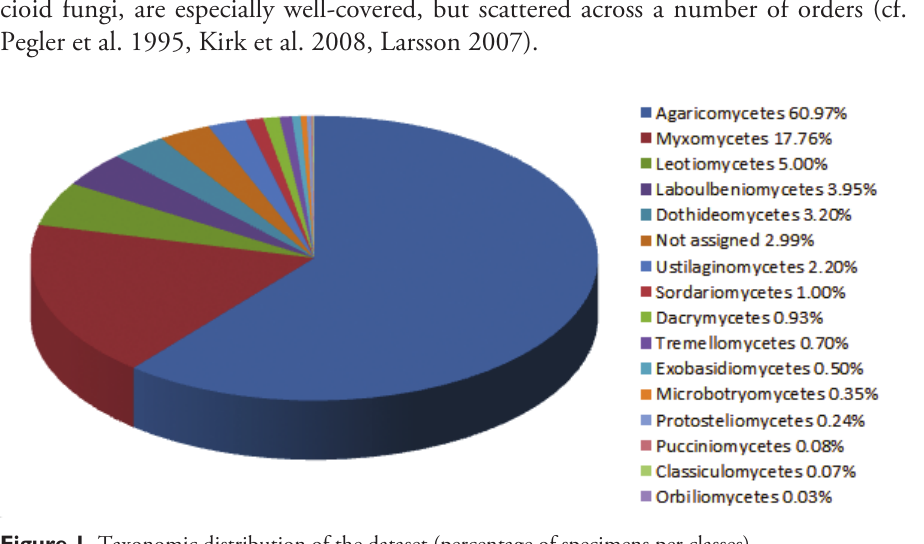
Figure 1. Taxonomic distribution of the dataset (percentage of specimens per